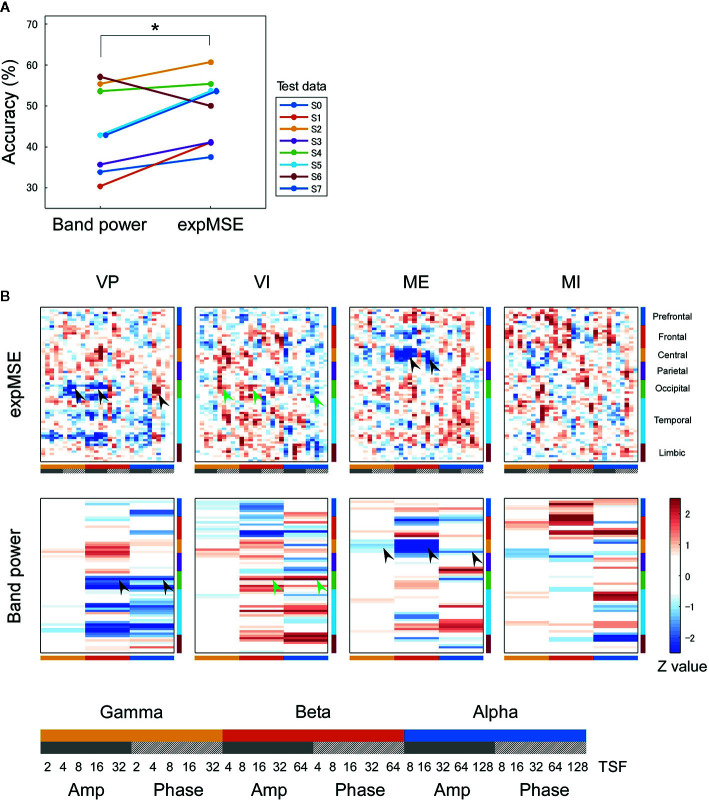
Inter-subject decoding of each task. (A) Decoding accuracies compared by band power and expMSE. Each color corresponds to a subject used for test data. *p < 0.05. (B) Task-related sensitivity maps. Upper and lower panels respectively portray maps for the expMSE and band power (VP, visual perception; VI, visual imagery; ME, motor execution; MI, motor imagery; black arrow, modality-specific sensitivity; green arrow, inverted sensitivity in the modality-specific regions). At the bottom are details of the horizontal axes: frequency × component (Amp/Phase) × TSF; Amp, amplitude expMSE; Phase, phase expMSE.